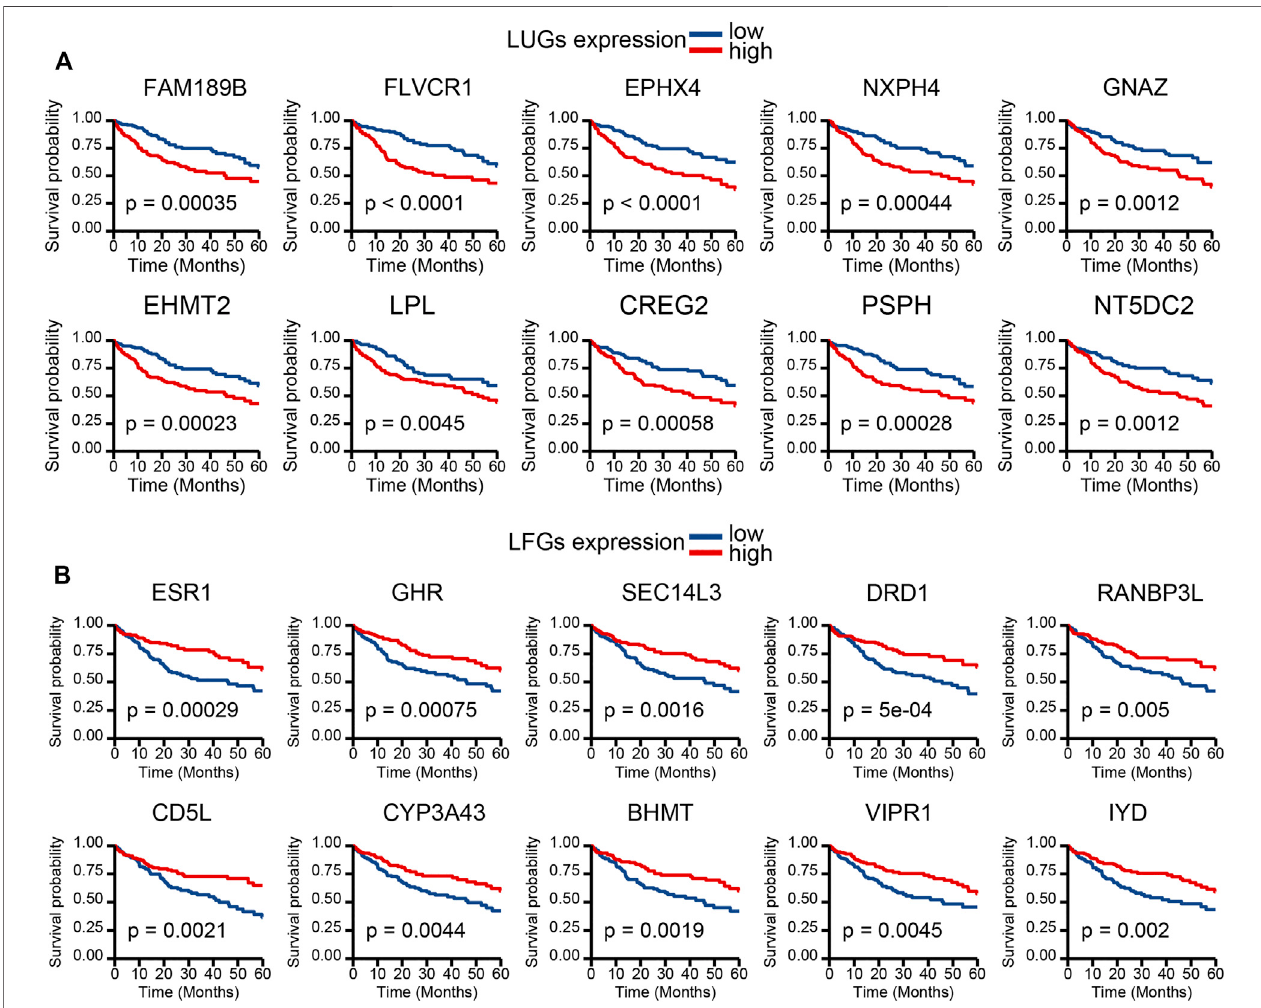
FIGURE 3 | Survival analysis. (A) KM survival curve of 10 most signi fi cant LIHC-unfavorable genes. (B) KM survival curve of 10 most signi fi cant LIHC- favorable genes.